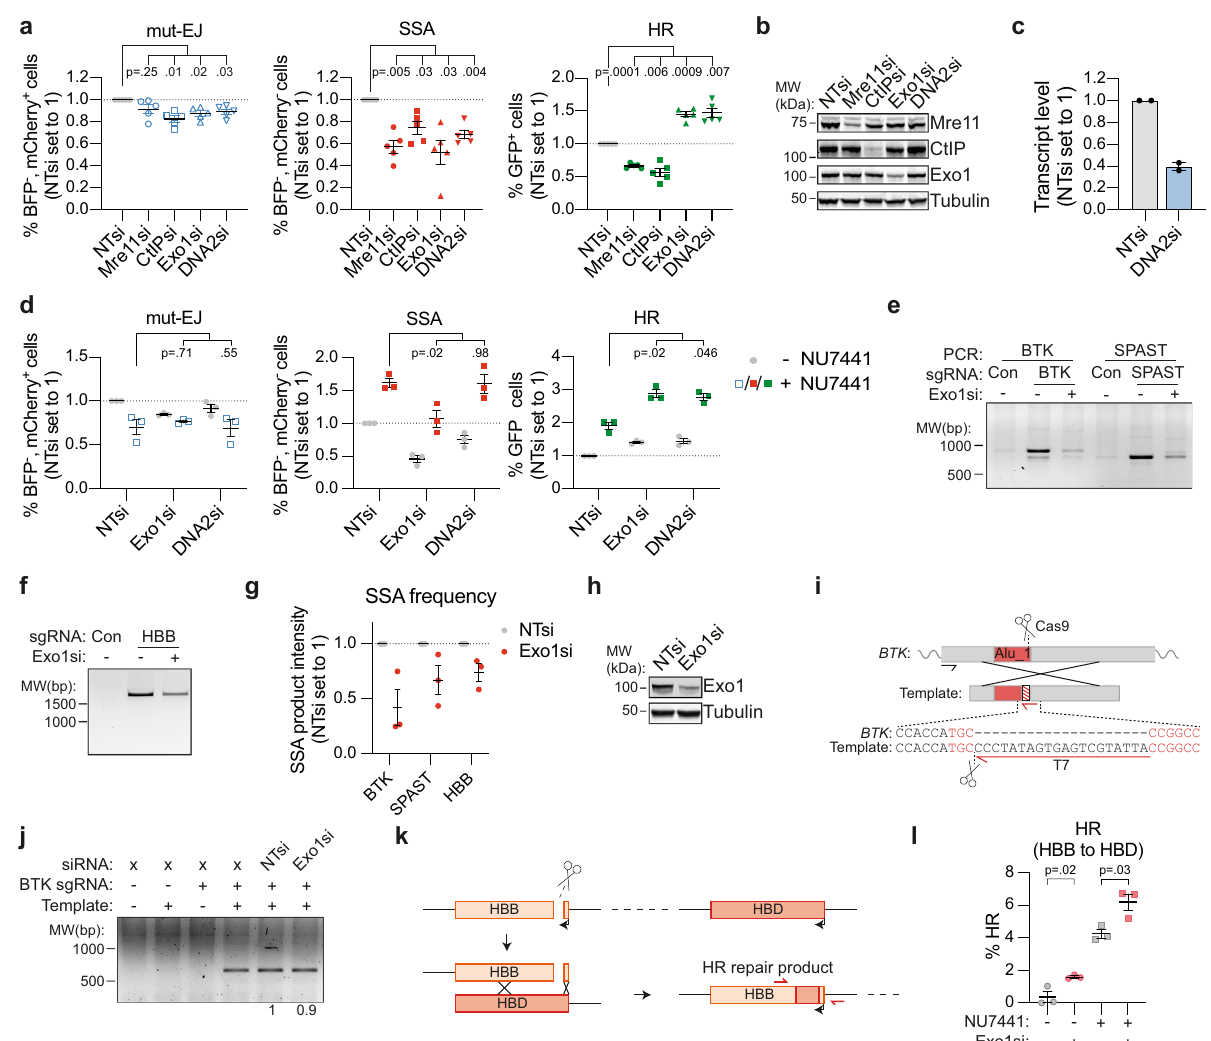
Fig. 6 | The long-range end-resection factors Exo1 and DNA2 are required for SSA, but inhibit HR. a DSB-Spectrum_V3 cells were transfected with indicated siRNAs, followed by transfection with Cas9 and ansgRNA targeting a control locus orBFP.Next,cellswereanalyzedby fl owcytometry,andrepairpathwaysquanti fi ed as in Fig. 1e ( n =5; mean±SEM; One-way ANOVA, post-hoc Dunnett ’ s). b Western blot of lysates fromcellsanalyzedin panel a . c Quanti fi cationbyqRT-PCR of DNA2 knockdown in cells used in panel a . Plotted are the mean and SEM of two inde- pendent qPCR experiments each done with a different primer pair. d As in panel a , in cells treated with or without NU7441 (2 µ M; n =3; mean±SEM; One-way ANOVA, post-hoc Dunnett ’ s). e – g HEK 293T cells were transfected with a non- targeting controlsiRNA( “ - ” lanes)orExo1siRNA,thenretransfected withindicated Cas9-sgRNA constructs (Con=AAVS1-targeting). SSA DSB-repair products were PCR ampli fi ed from genomic DNA.Panels e and f show a representative gel image,